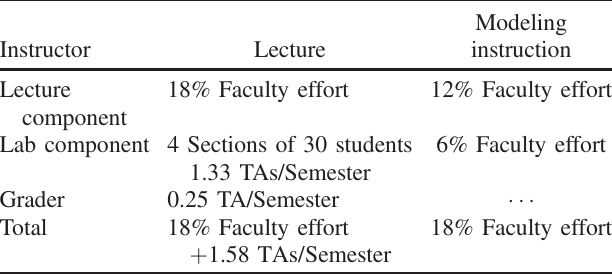
TABLE I. Instructional effort for teaching introductory physics in both the Modeling Instruction and lecture